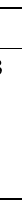
Table 2. Values of the fitting parameters ( k and n ) for the power-law response model defined in Equation (2). These values correspond to the experimental data presented in Figure 6.